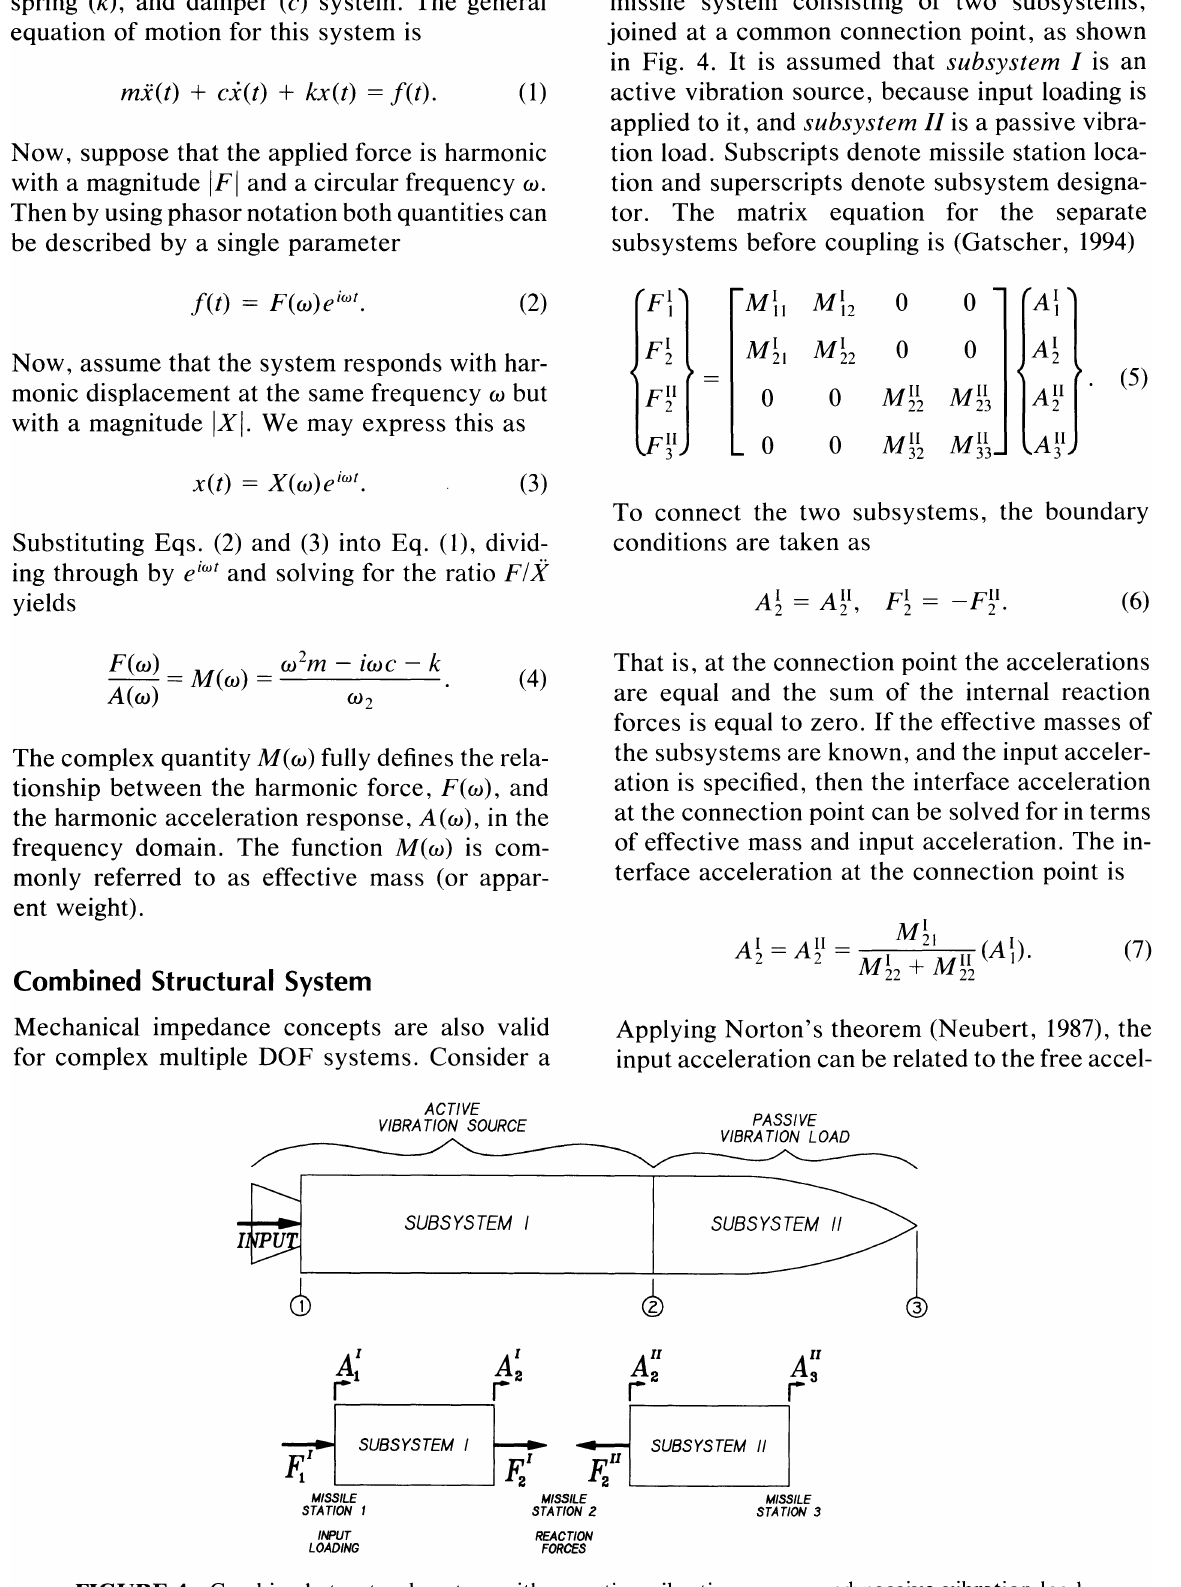
FIGURE 4 Combined structural system with an active vibration source and passive vibration